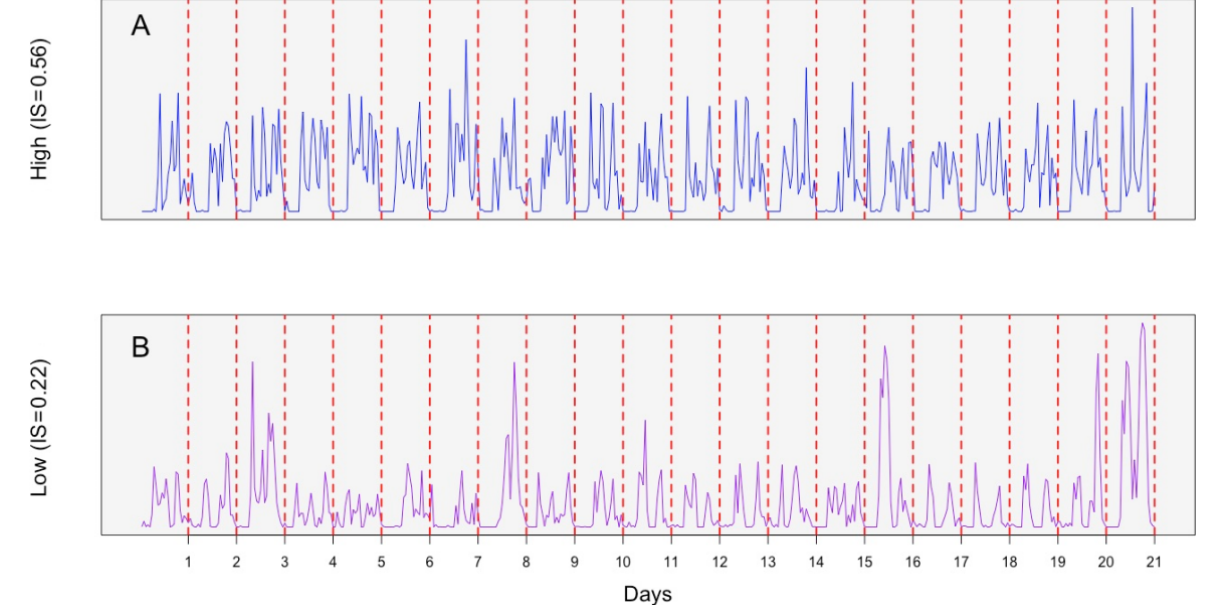
Figure 1. Steps tracking charts. Individuals with relatively high (A) and low (B) interdaily stability but similar total daily steps. x-axis: time in days. y-axis: steps count. IS: interdaily stability of locomotor activity